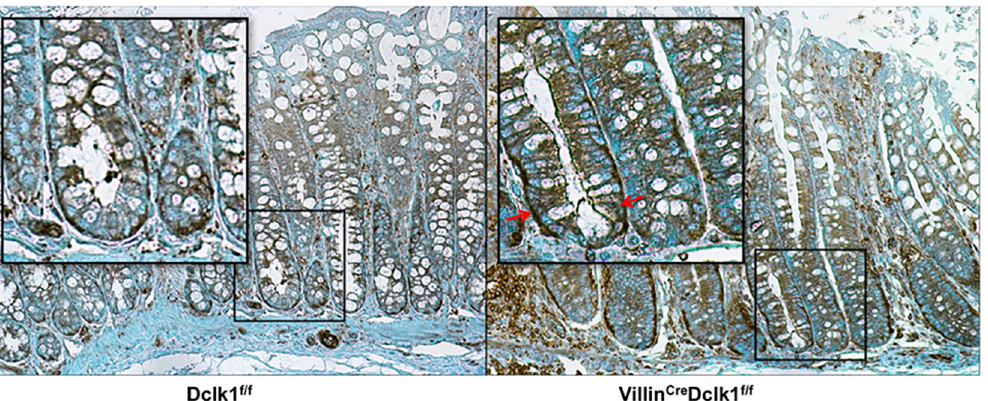
Fig 5. Deletion of Dclk1 increases NF- κ B expression following DSS treatment. The expression of NF- κ B p65 (Brown) was identified by immunostaining with anti-p65 antibody. Occasional nuclear localization of p65 was indicated by arrow in Villin Cre ;Dclk1 f/f mice. Alcian blue was used for counterstaining.